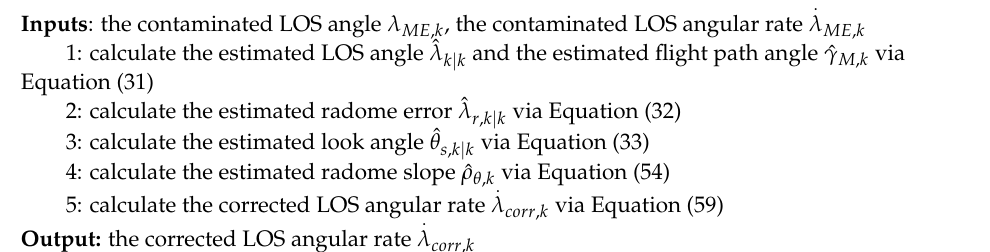
Algorithm 1: Pseudo code for the proposed LOS angular rate corrector at the k th time